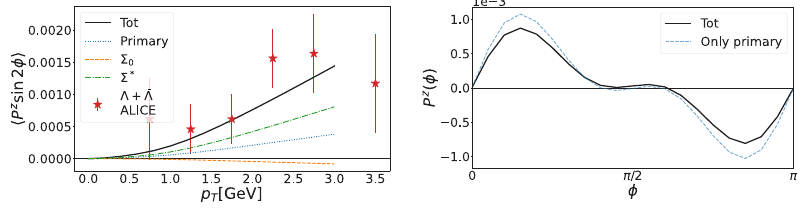
Figure 2. Calculations of the polarization vector at 5020 GeV. Left panel: second Fourier harmonic of P z , similar as figure 1. The data points are taken from [19]. Right panel: comparison between P z before and after the inclusion of feed down, much like fig. 1. In this simulation, a non-vanishing bulk viscosity has been